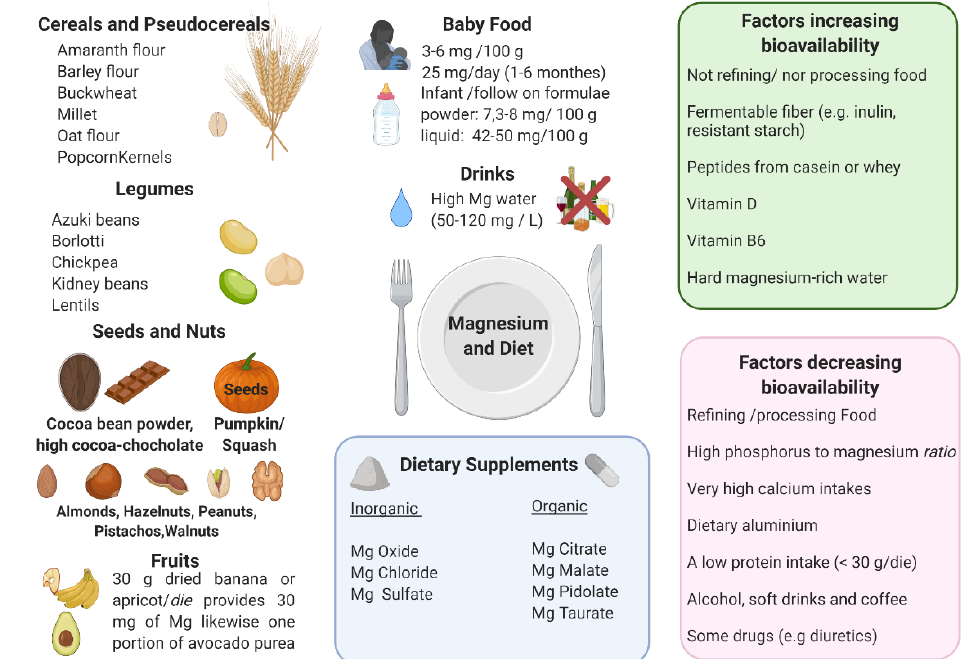
Figure 2. Magnesium and Diet. Main sources of magnesium, magnesium supplements, and factors that increase or decrease magnesium bioavailability are schematized. This image is created with BioRender.com .